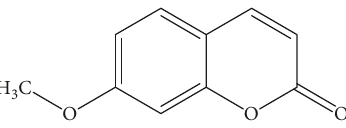
Figure 1: 7-Methoxycoumarin (molecular weight = 176 1 M ; molecular formula = C